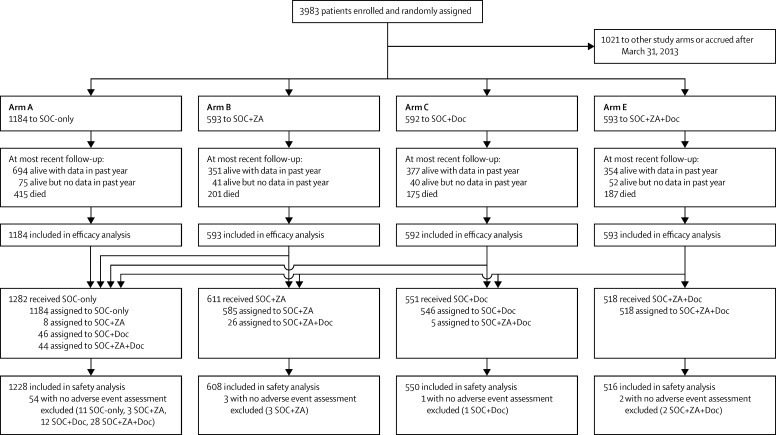
Trial profileSOC-only=standard of care only. SOC + ZA=standard of care plus zoledronic acid. SOC + Doc=standard of care plus docetaxel. SOC + ZA + Doc=standard of care plus zoledronic acid and docetaxel.